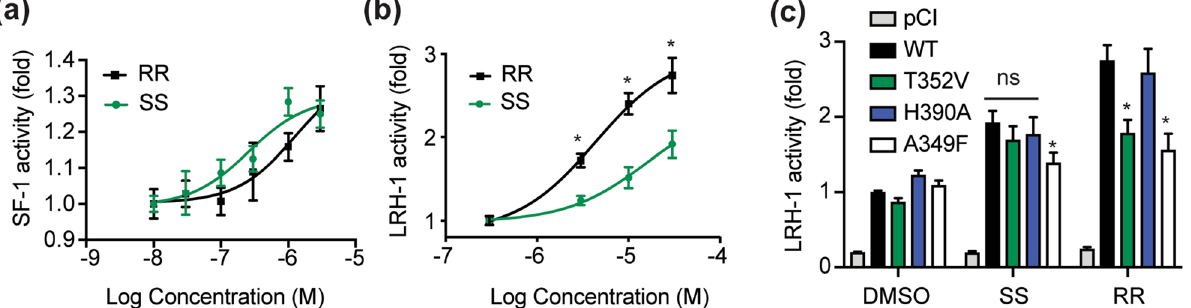
Figure 4. Effects on receptor transcriptional activity. ( a , b ). Luciferase reporter assays measuring transcriptional activity of full-length SF-1 ( a ) or LRH-1 ( b ) in Hela cells. Each point represents the mean fold change versus DMSO-treated cells ± SEM for three experiments each conducted in triplicate. Significance of differences in activity was determined by two-way ANOVA, followed by Sidak’s multiple comparisons test. *p < 0.05 versus SS-RJW100. ( c ) Mechanistic differences LRH-1 activation by SS-RJW100 compared to related molecules. Wild- type (WT) or mutant LRH-1 was overexpressed in Hela cells prior to treatment with 30 µM RR- or SS-RJW100. Each bar indicates mean fold change (± SEM) in LRH-1 activity after agonist treatment for 24 h relative to DMSO-treated cells. The experiment was conducted three times in triplicate. Fold change is calculated relative to DMSO-treated cells overexpressing WT LRH-1. Significance was determined by two-way ANOVA followed by Sidak’s multiple comparisons test. *p < 0.05 versus DMSO-treated cells for each group of bars (WT, mutant, or pCI empty vector. The A349F mutation introduces a bulky amino acid that blocks the binding pocket and was used as a negative